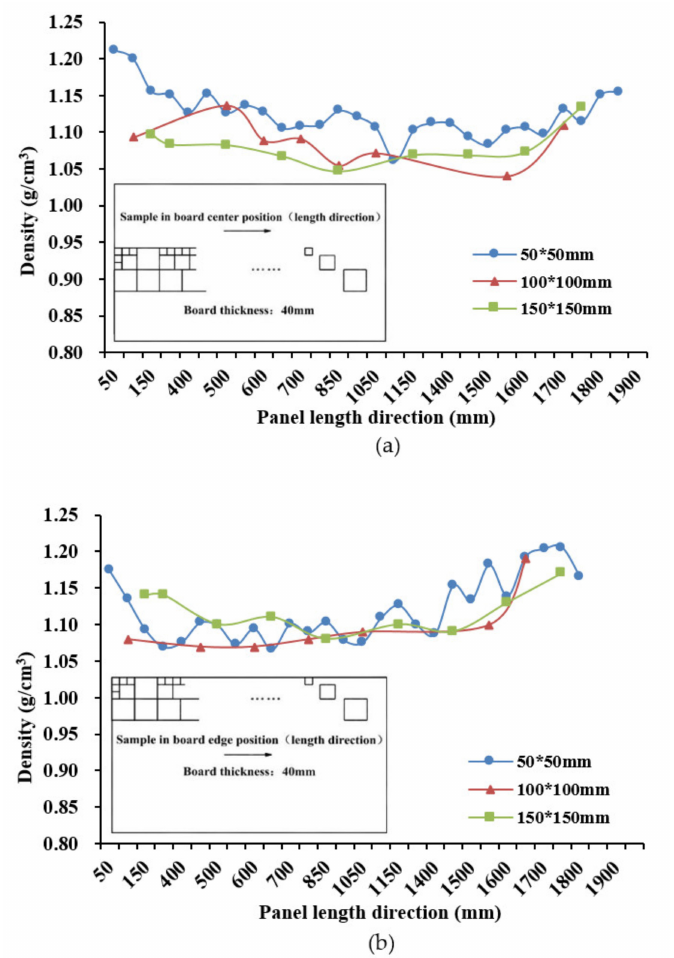
Figure 8. Density distribution along panel length for ( a ) centerline and ( b ) edge of